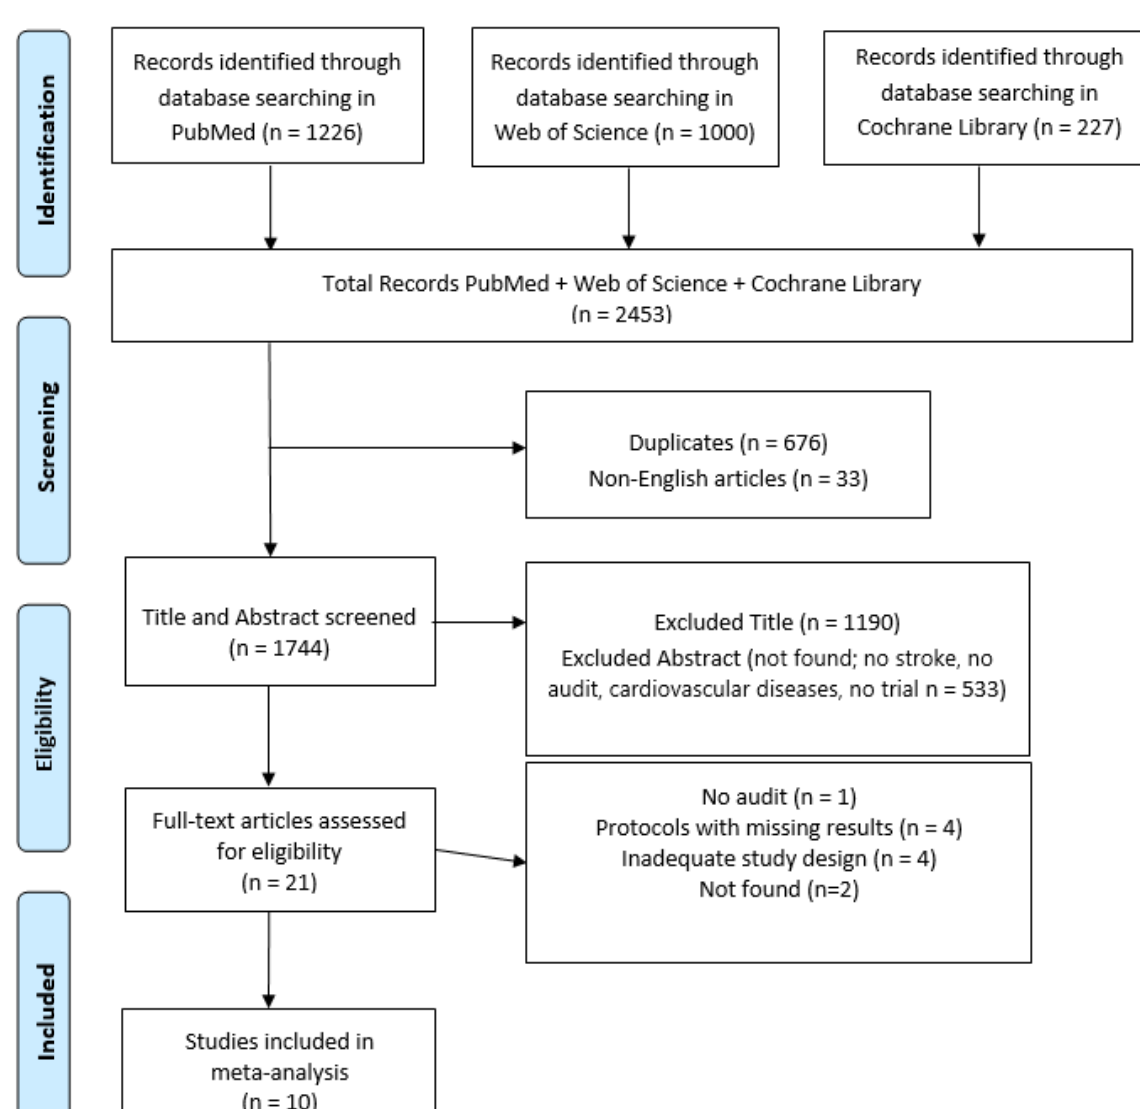
Figure 1. Graphic of identification, screening, eligibility, and inclusion of review article.